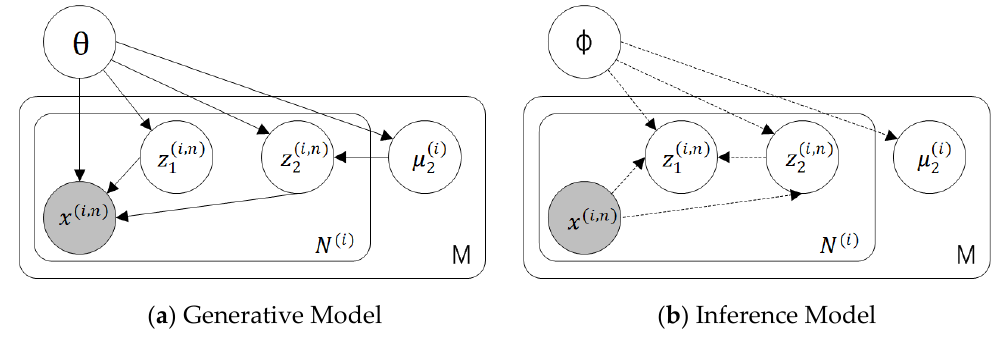
Figure 1. Graphical illustration of the factorized hierarchical variational autoencoders (VAEs). Grey nodes denote the observed variables, and white nodes are the hidden variables.